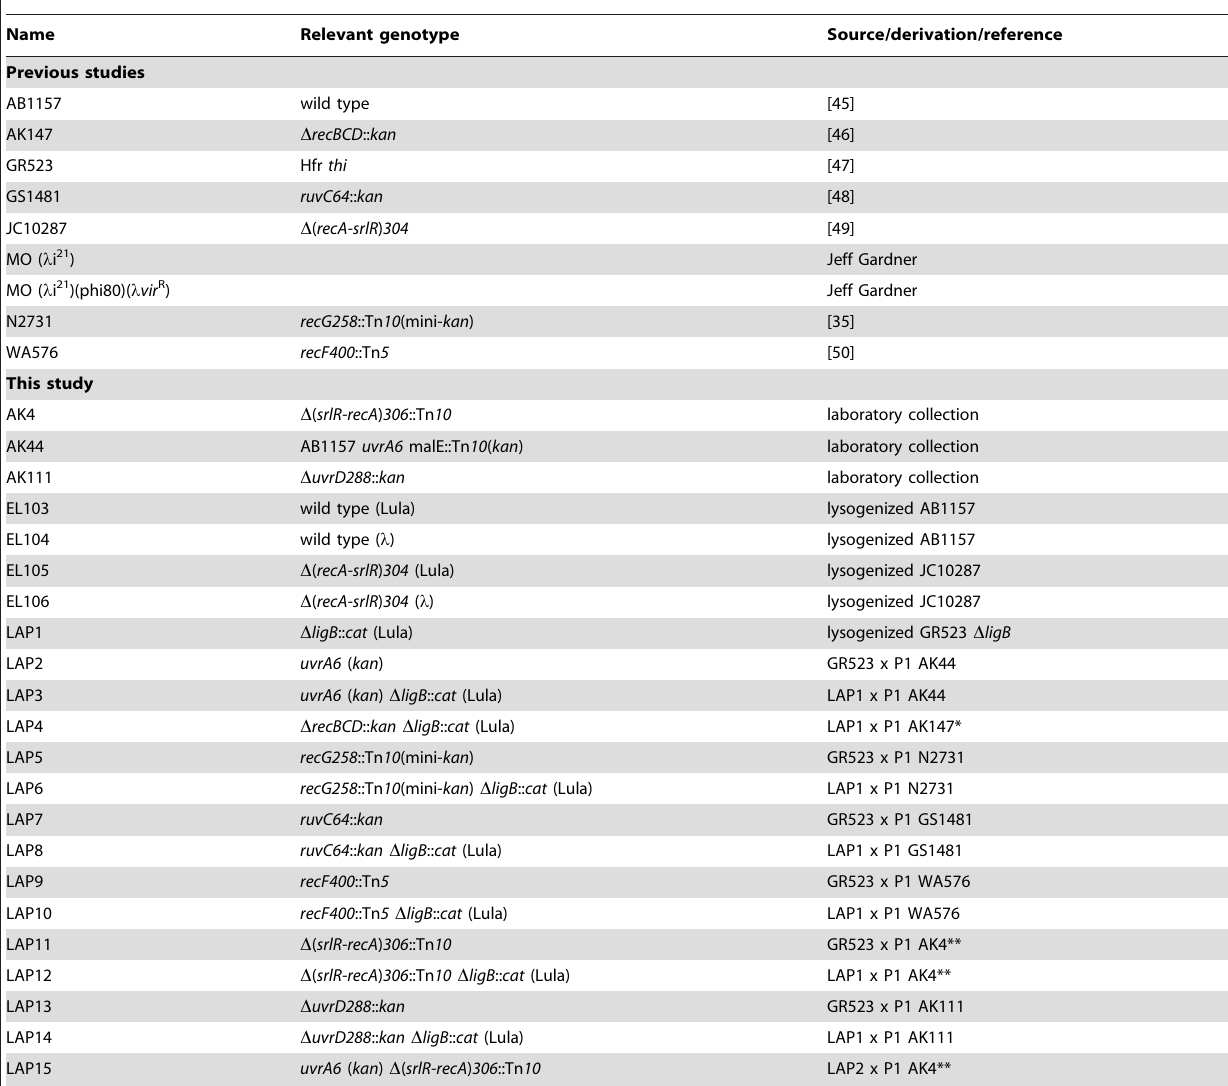
Table 1. Bacterial strains used in this